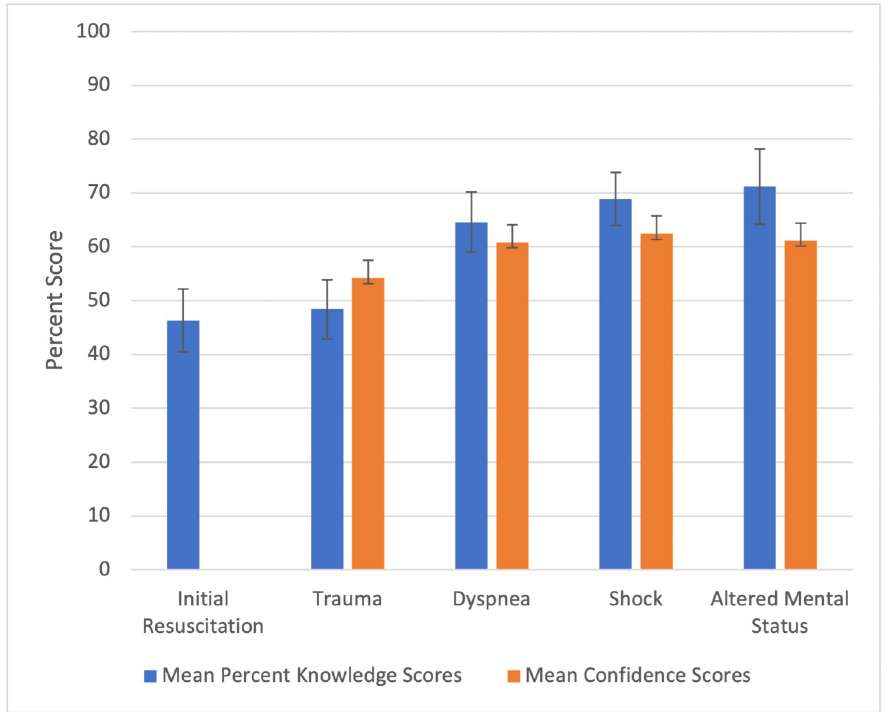
Fig 2. Mean percent knowledge sores and confidence scores amongst graduating medical students across Colombia by subject areas taught in the WHO basic emergency care course. � Confidence not measured for Initial